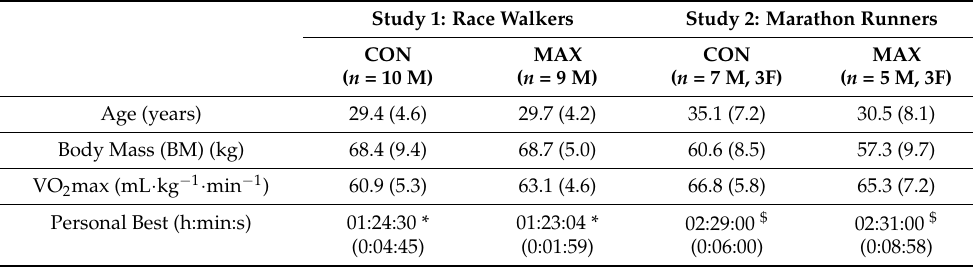
Table 1. Baseline characteristics of participants. Study 1: Race Walkers Study 2: Marathon